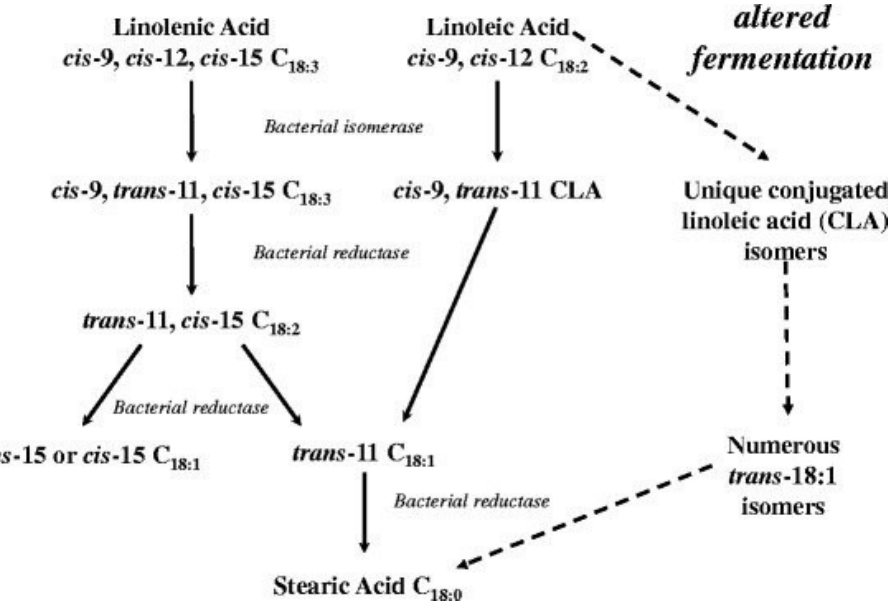
Figure 1. Biohydrogenation pathways of linolenic, linoleic, and acids [25].